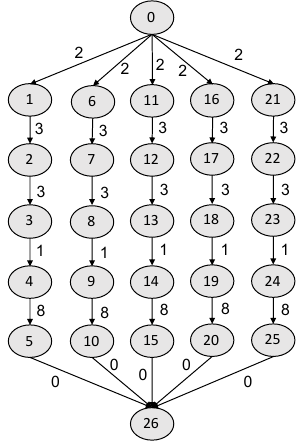
Figure A1. A more complicated WiFi job profile. The job has 25 tasks. Table A1. A more complicated WiFi resource profile. There are 7 different types of